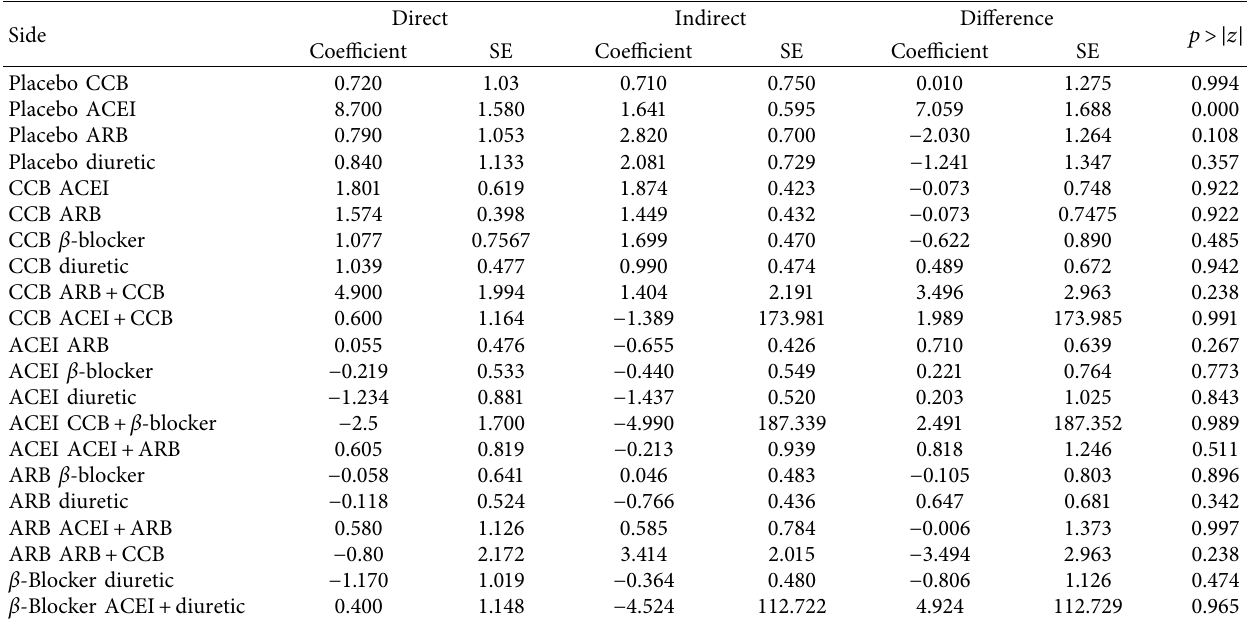
Table 2: Inconsistency test between direct and indirect treatment comparisons in mixed treatment comparison in FMD.